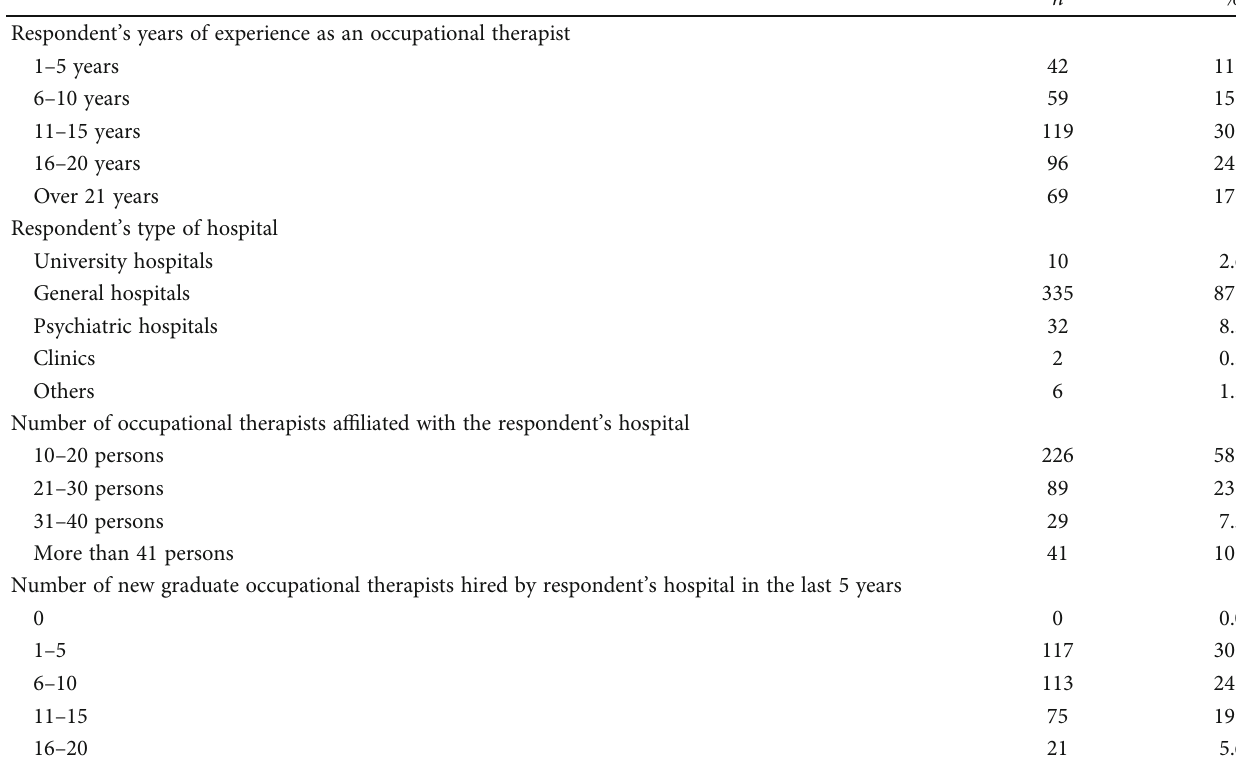
Table 1: Basic information about the respondents and their hospitals ( n = 385